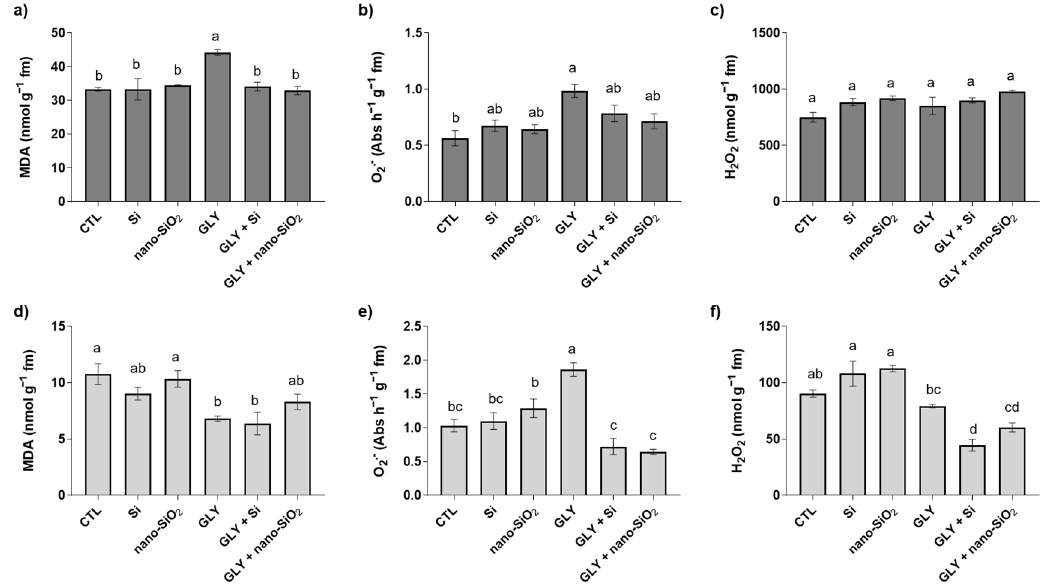
Figure 4. Oxidative stress markers of S. lycopersicum plants after 4 weeks of growth. ( a , d ) malondialdehyde (MDA); ( b , e ) superoxide anion (O 2 •− ) and ( c , f ) hydrogen peroxide (H 2 O 2 ). Dark and light bars represent shoots and roots, respectively. Data presented are mean ± STDEV ( n ≥ 3). Different letters (a–d) above bars indicate significant statistical differences between treatments (Tukey: p ≤ 0.05).